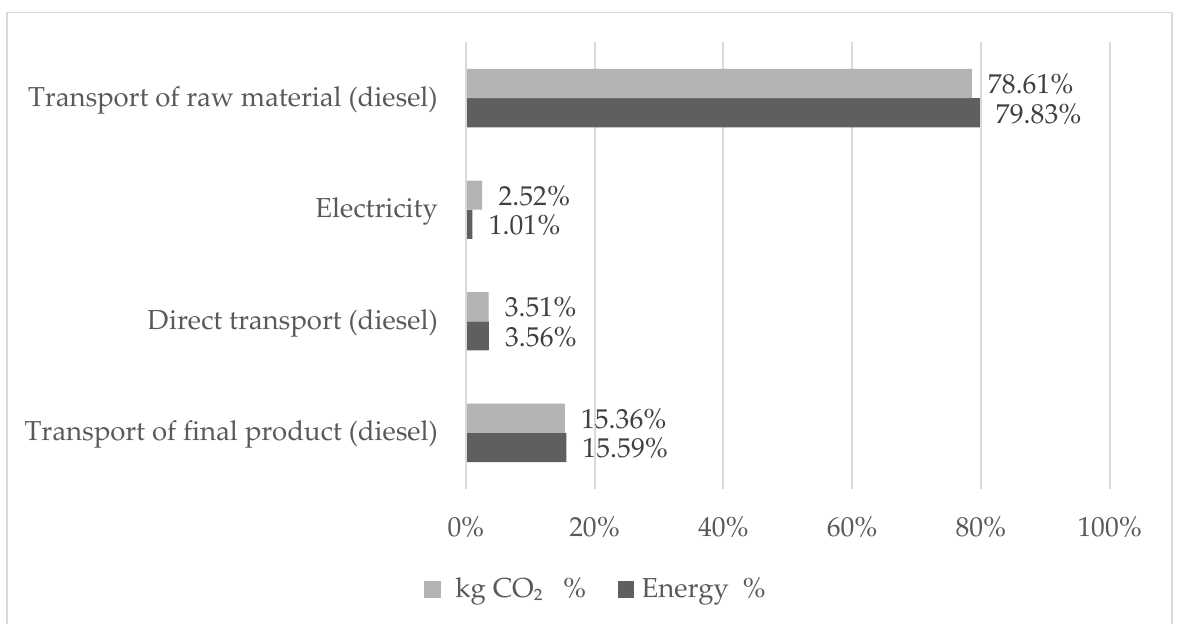
Figure 4. Embodied energy and CO 2 emissions from the transport of each raw material.